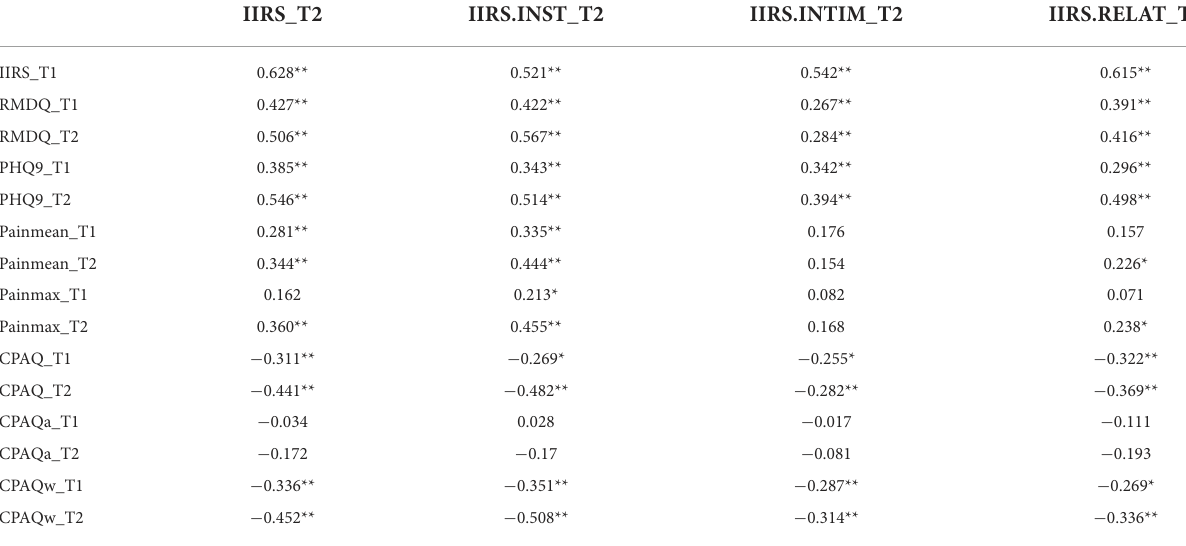
TABLE 3 Correlation between follow-up (T2) illness intrusiveness and the measures of pain, functionality, and psychological factors at baseline (T1) and follow-up